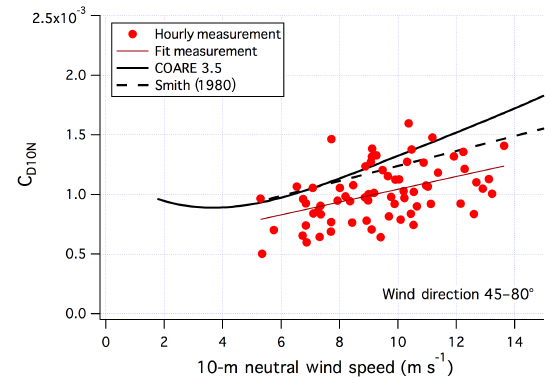
Figure A2. 10m neutral drag coefficient vs. 10m neutral wind speed for the air–water wind sector.